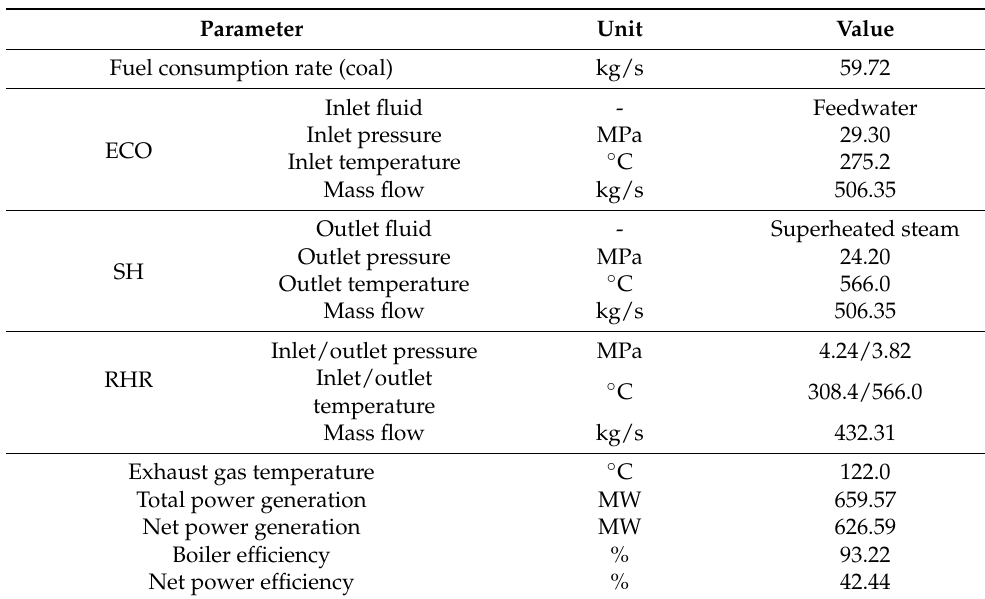
Table 6. Major parameters of the